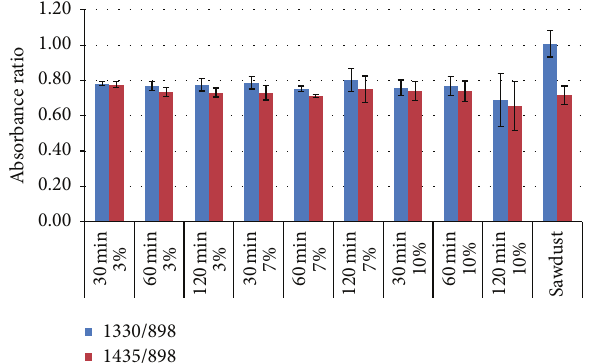
Figure5:Absorbanceratiosof A 1330 / A 898 and A 1435 / A 898 forsawdust pretreated with NaOH at 60 ∘ C.